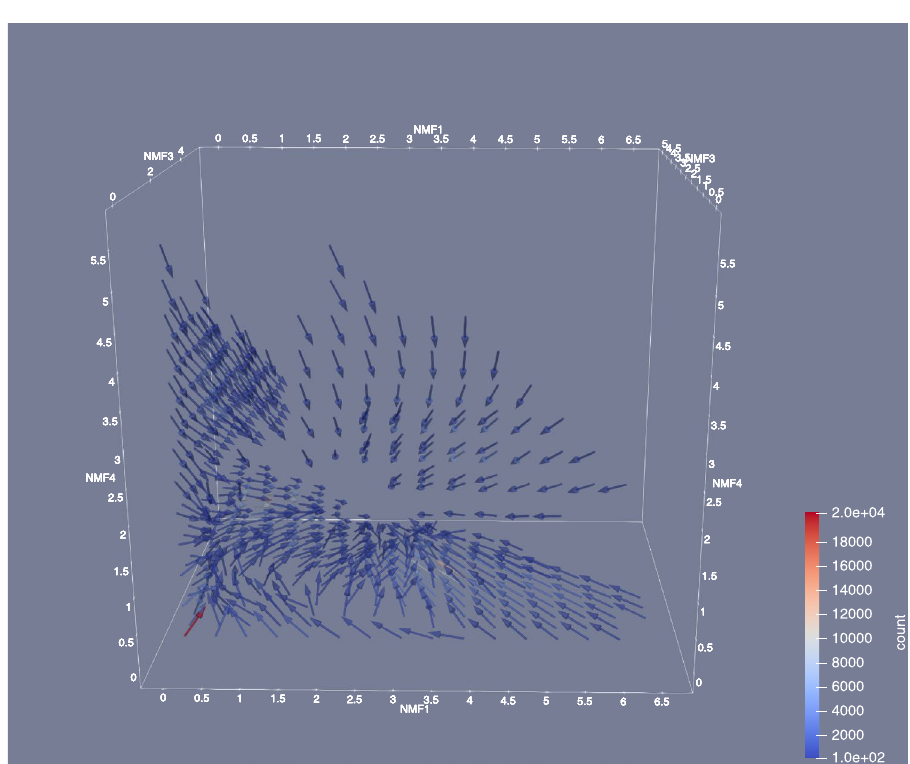
Figure 8. Average direction of flow of the systems in reduced space. The colors or arrows represent the number of samples in each cell. Only the flows of cells that include more than 100 samples are shown. The lengths of the arrows are not scaled, because the velocity at (NMF1, NMF3, NMF4) ∼ ( 0, 0, 0 ) was too small, thus,